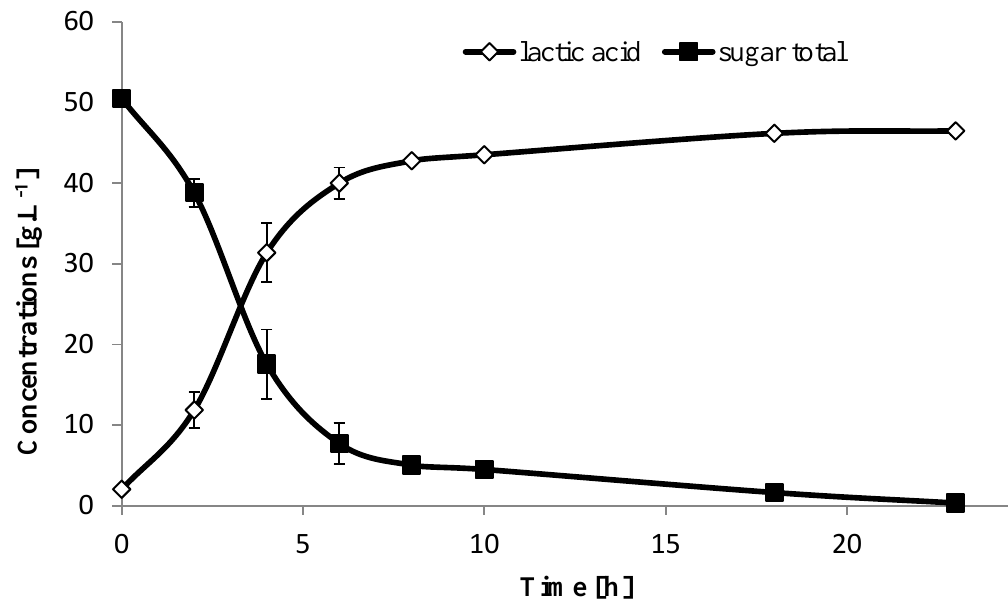
Figure 2. Lactic acid production and remaining sugars trend during 24 h fermentation after hydrolysis of sugarcane biomass (15% DM) of 2019 harvest using isolate A166. Each data point represents the mean of 3 replicates ± SD.